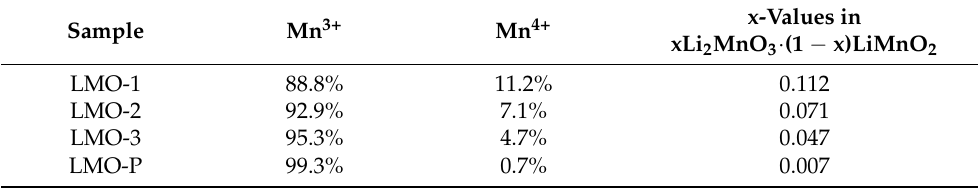
Table 2. Different manganese valences and their respective content obtained using the chemical